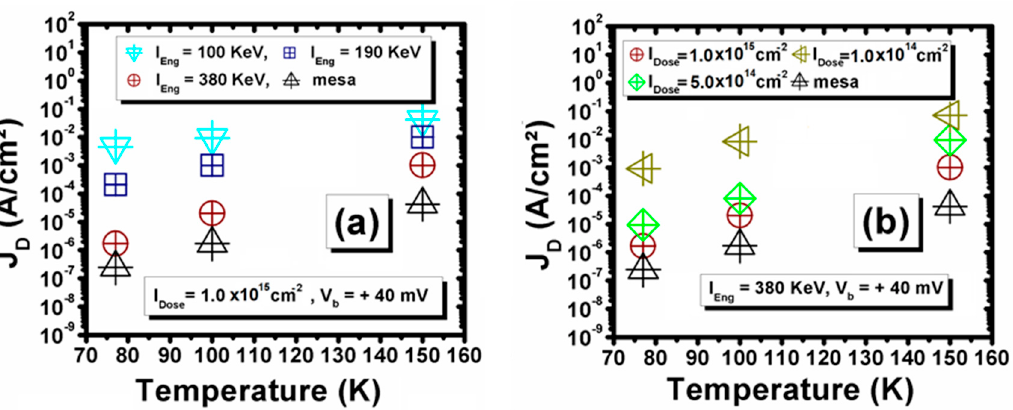
Figure 2. ( a ) J D values vs. temperature for mid-wavelength infrared (MWIR) PT2SL photodetectors with I Eng of 380 KeV and different I Dose . ( b ) JD values vs. temperature with I Dose = 1.0×10 15 cm − 2 and different I Eng . All diodes were circular with a 200 µm diameter and the applied bias (V b ) is +40 mV.